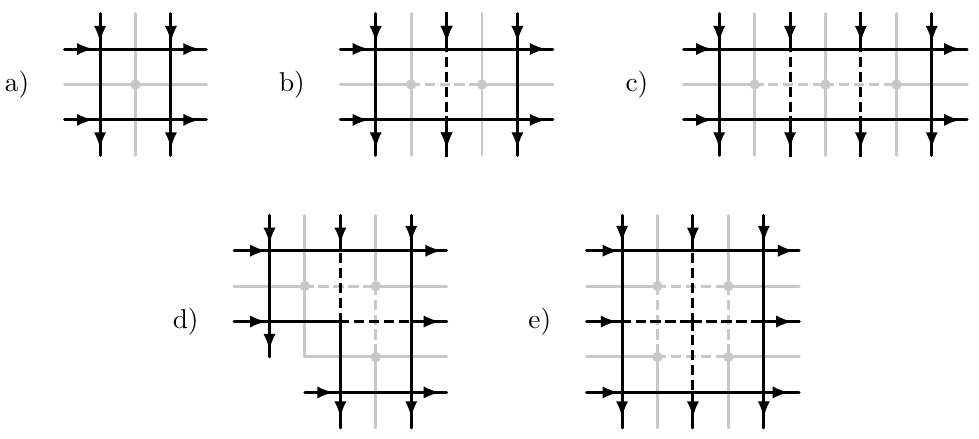
Figure 3 . Momentum-space Feynman diagrams (black) in one-to-one correspondence with one- particle-irreducible color-ordered amplitudes in the planar limit of the massive fishnet theory. Solid (dashed) lines correspond to massive (massless) propagators. Gray lines indicate the dual graph corresponding to the same Feynman integral expressed in terms of region